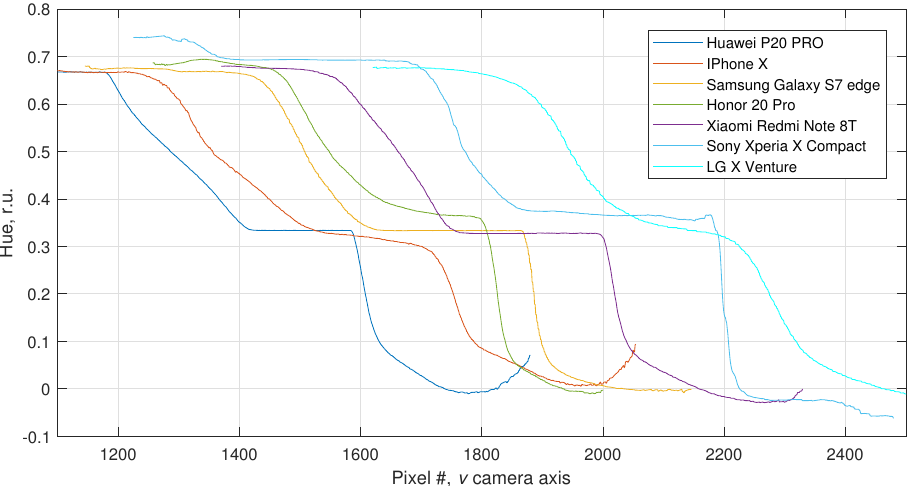
Figure A2. Comparison of hue distribution of spectra images measured with 7 different